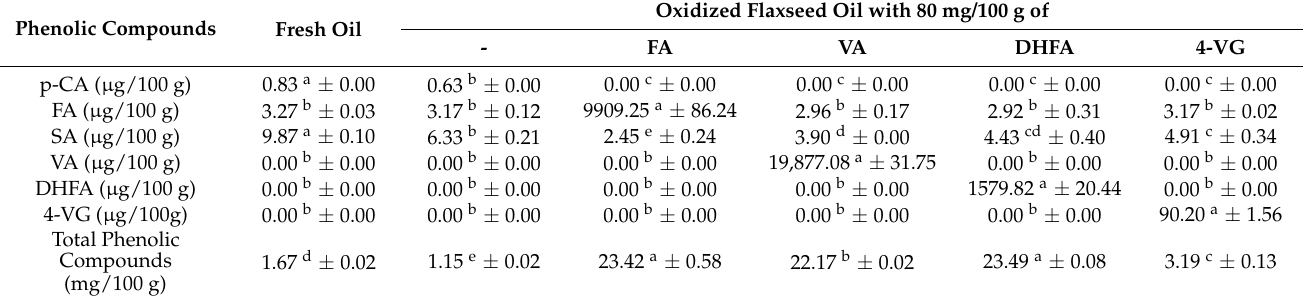
Table 5. Content of phenolic compounds (x ± SD) in fresh cold-pressed flaxseed oil and oxidized oil at 60 ◦ C without and with phenolic